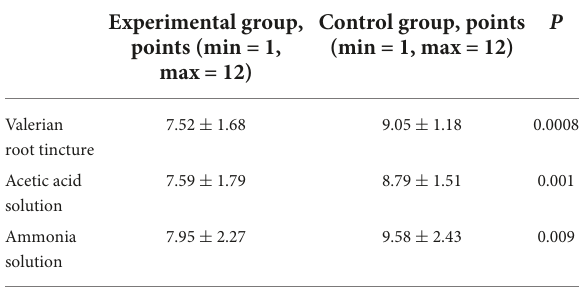
TABLE 3 The mean scores of olfactory threshold.